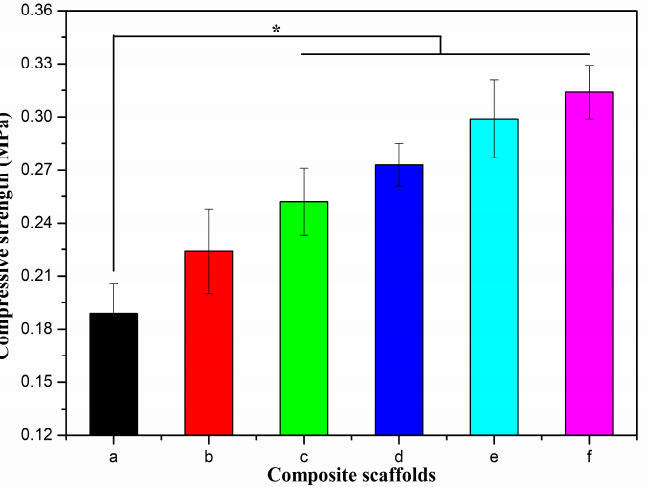
Figure 4. Compressive strength of composite scaffolds: ( a ) Alg-CS-GT, ( b ) Alg/0.1% BCNs-CS-GT, ( c ) Alg/0.2% BCNs-CS-GT, ( d ) Alg/0.3% BCNs-CS-GT, ( e ) Alg/0.4% BCNs-CS-GT and ( f ) Alg/0.5% BCNs-CS-GT. * represents p < 0.05, indicating significant difference.